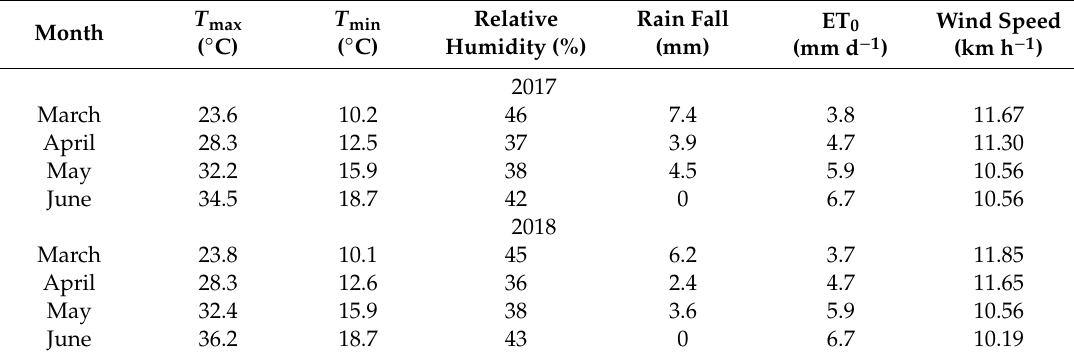
Table 1. Average monthly maximum ( T max ) and minimum ( T min ) temperature, relative humidity, rainfall, evapotranspiration (ET 0 ), and wind speed during growing